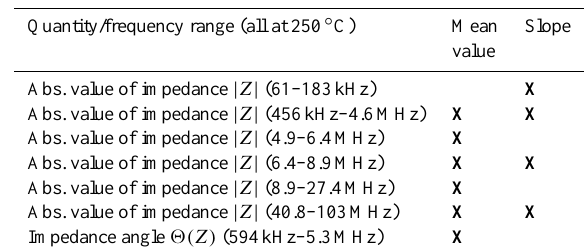
Figure 7. Sensor impedance of UST 1330 at 61kHz, in air (50%rh, black lines) and in air with 50ppm CO (red lines) during temper- ature cycle. The solid lines show the impedance of the unimpaired sensor; the dashed lines show the impedance values of the same sensor after its exposure to 70ppm HMDSO (hexamethyldisilox- ane) during 10min. Table 1. Features used for EIS-based